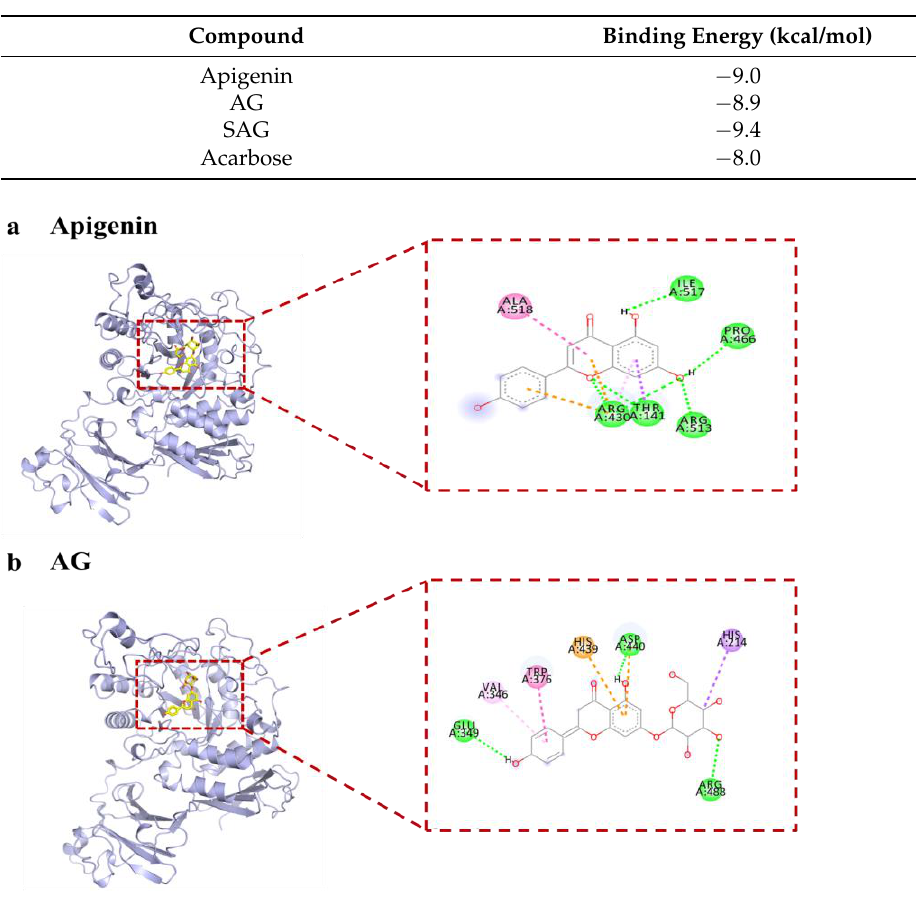
Figure 2. The interaction of active compounds with α -glucosidase (( a ) apigenin, ( b ) apigenin-7- O - β - (6″ - O -succinyl)- D -glucoside glucoside (AG), ( c ) apigenin-7- O - β - (6″ - O -succinyl)- D -glucoside (SAG), ( d ) acarbose).